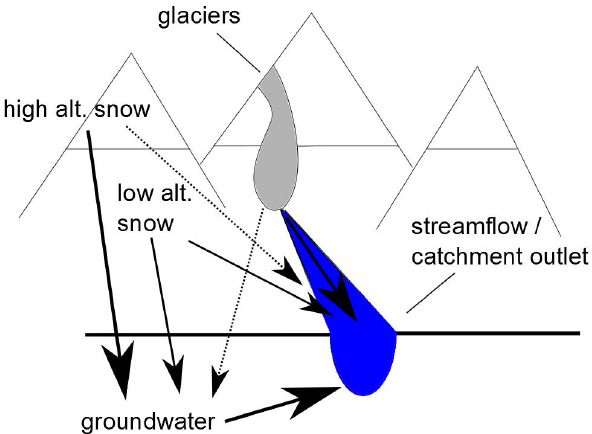
Fig. 3. Hypothesised flowpaths in the studied catchment. Thicker arrows indicates more important flowpaths. alt. =